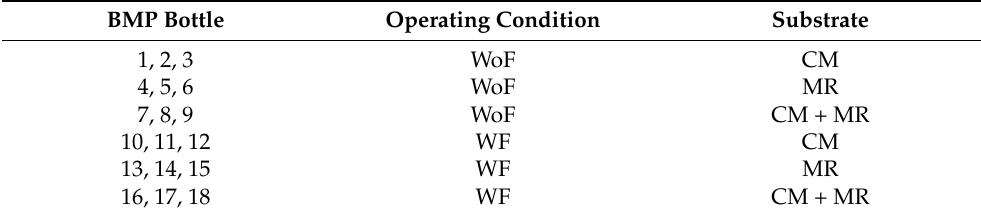
Table 3. Biomethane Potential (BMP) test setup.